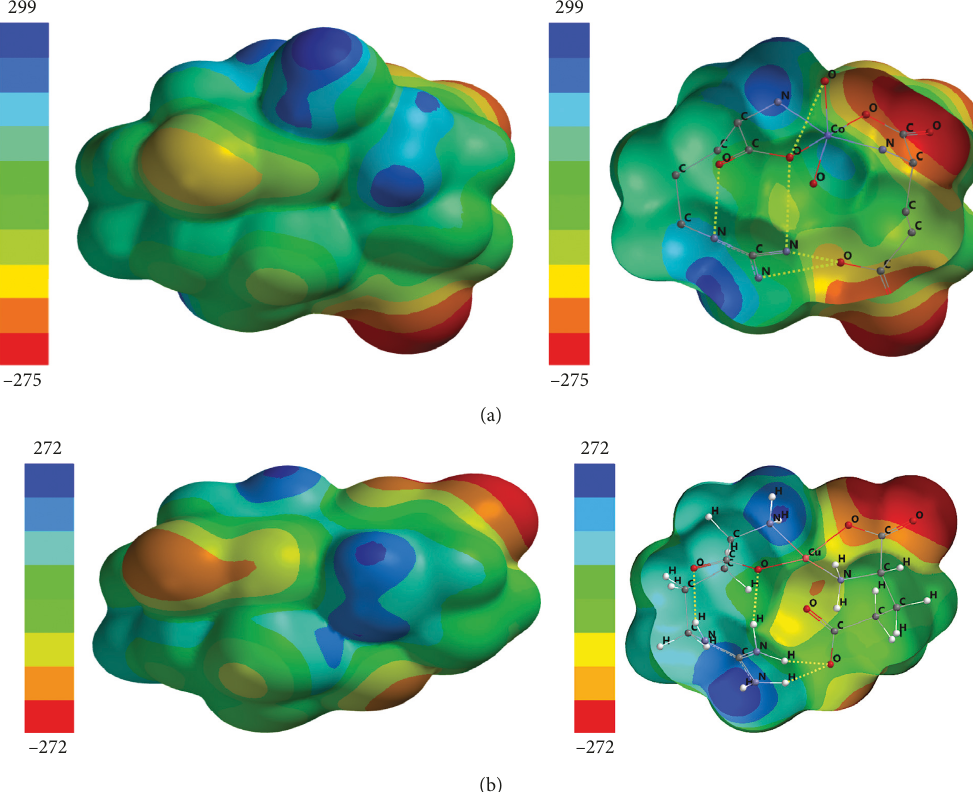
Figure 3: PES maps. (a) Co complex (upper pan: solid surfaces and lower pan: clipped surfaces) and legend color codes given in kJ/mol. (b) Cu complex (upper pan: solid surfaces and lower pan: clipped